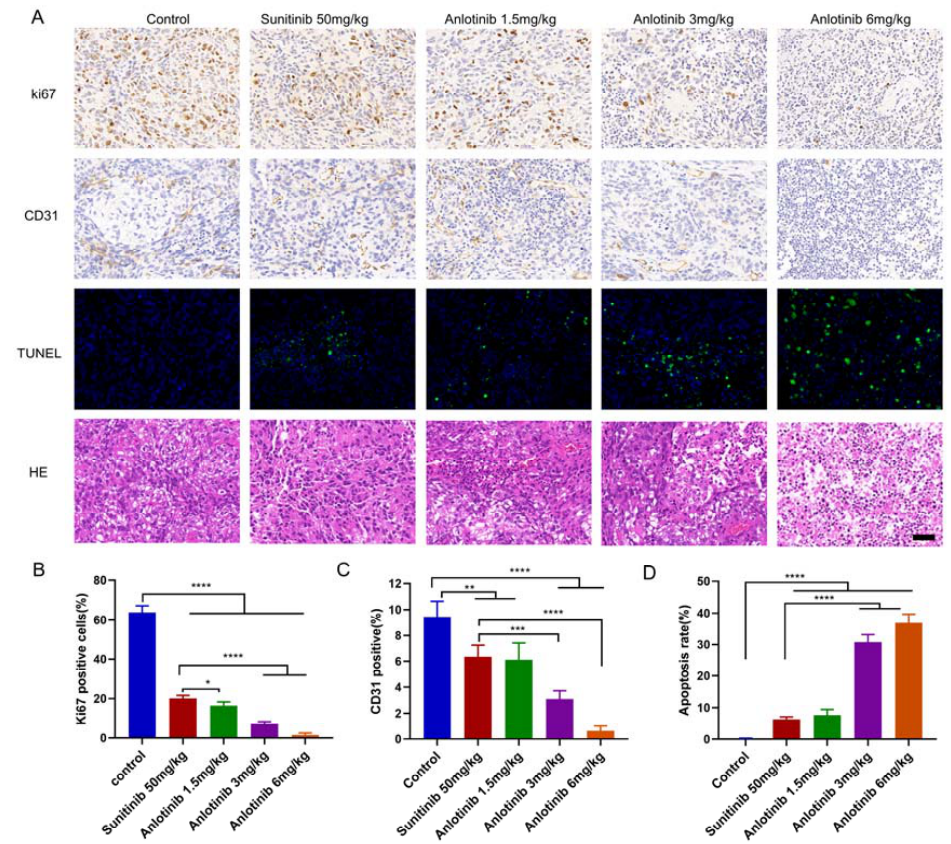
Figure 4. Anlotinib effectively inhibited tumor growth and angiogenesis, induced apoptosis in ovarian carcinoma peritoneal metastases model. ( A ) Representative images of TUNEL and IHC staining of Ki67 and CD31, and H&E staining of tumor tissues from various groups. Bar = 100 µ m ( B ) Ki67 positive rate of tumor tissues from various groups. ( C ) CD31 positive rate of tumor tissues from various groups. ( D ) Apoptosis rate of tumor tissues from various groups. The data are presented as the mean ± SD from three independent experiments. * p < 0.05; ** p < 0.01; *** p < 0.001; **** p < 0.0001.